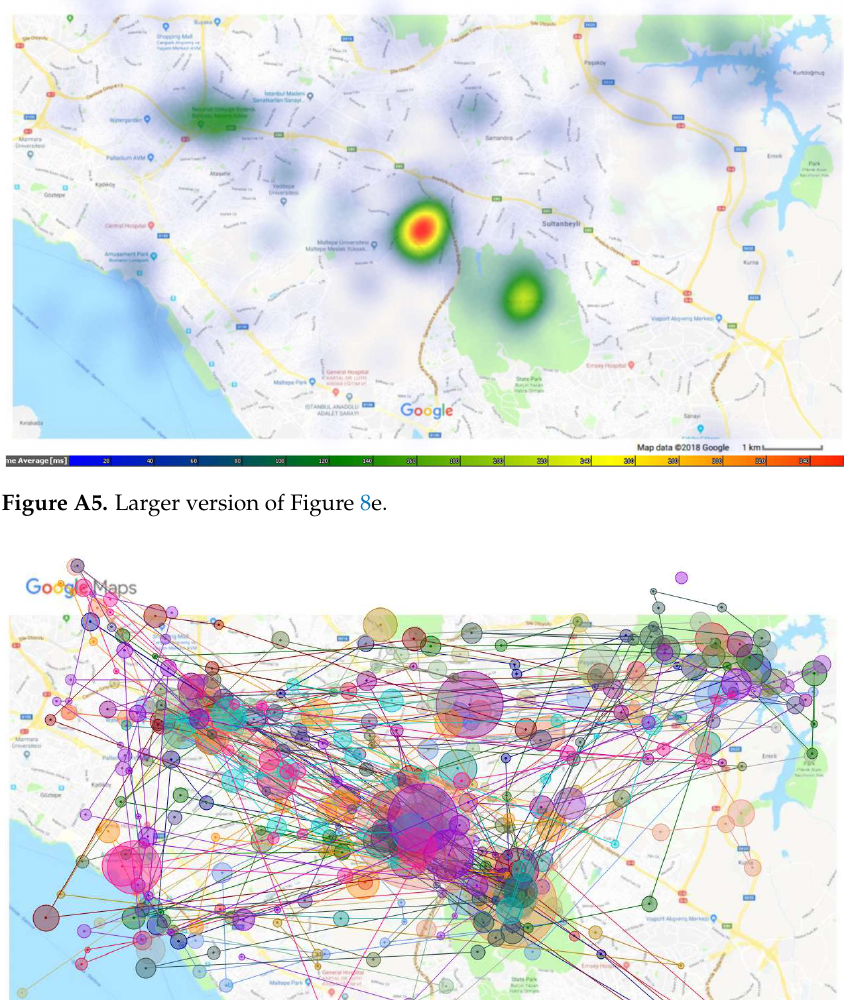
Figure A4. Larger version of Figure 8b.